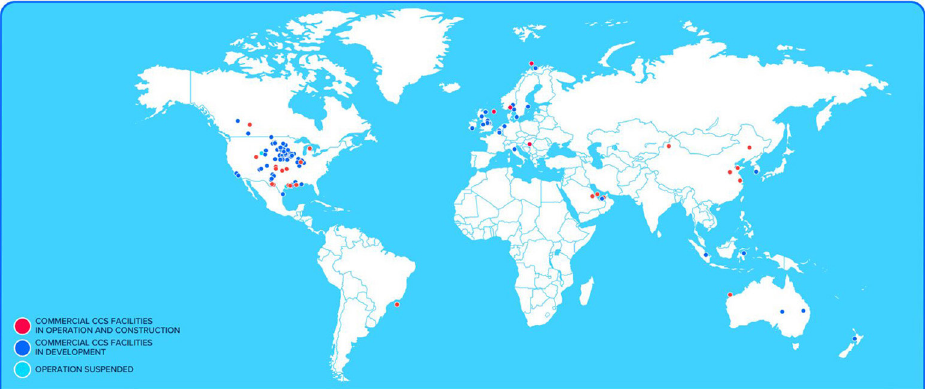
Fig. 3. – World map of CCS facilities at various stages of development